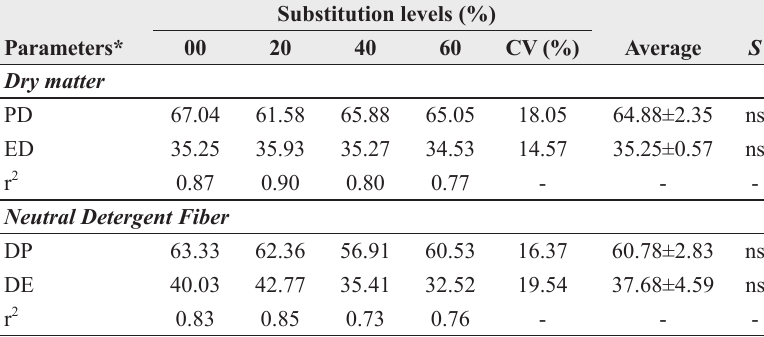
Potential degradability (PD) and effective degradability (ED) of dry matter and neutral detergent fiber, to B. brizantha cv Marandu, in steers supplemented with sunflower crushed in a partial replacement for soybean meal.